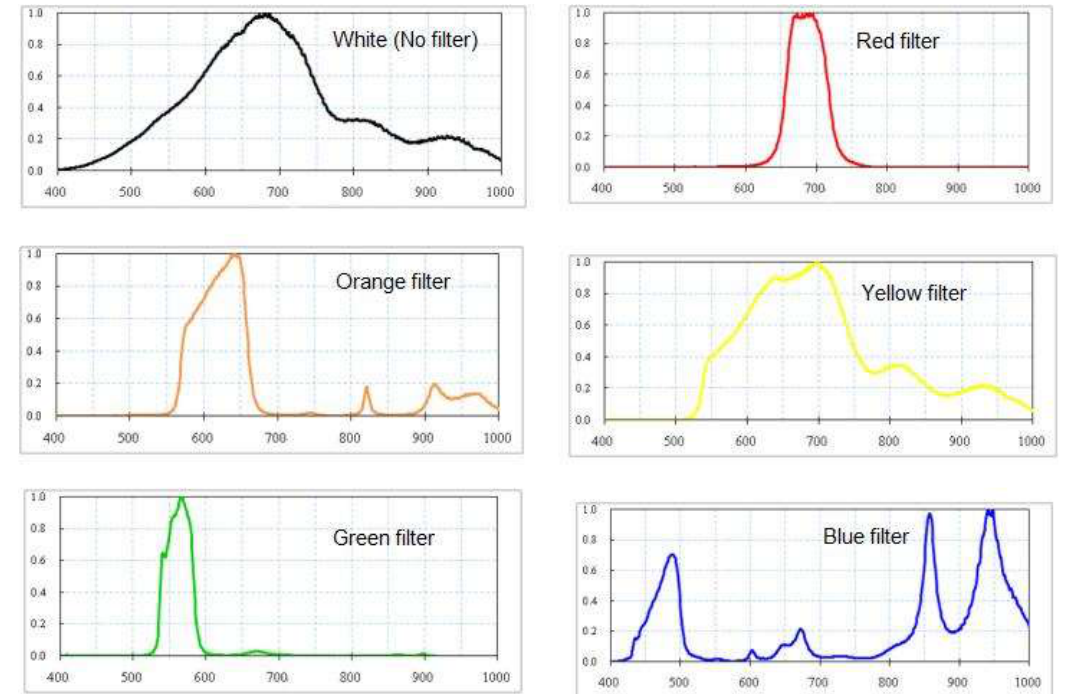
Figure 3. Spectrum distributions of quartz-halogen light sources.